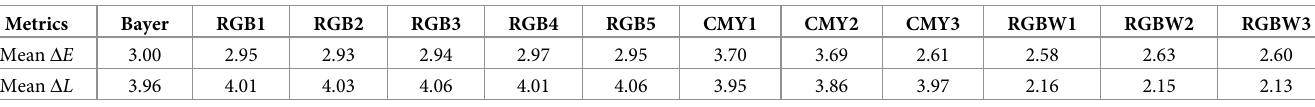
Table 1. Mean delta E for 24 color patches and mean delta L for 6 achromatic patches for test CFAs. Metrics